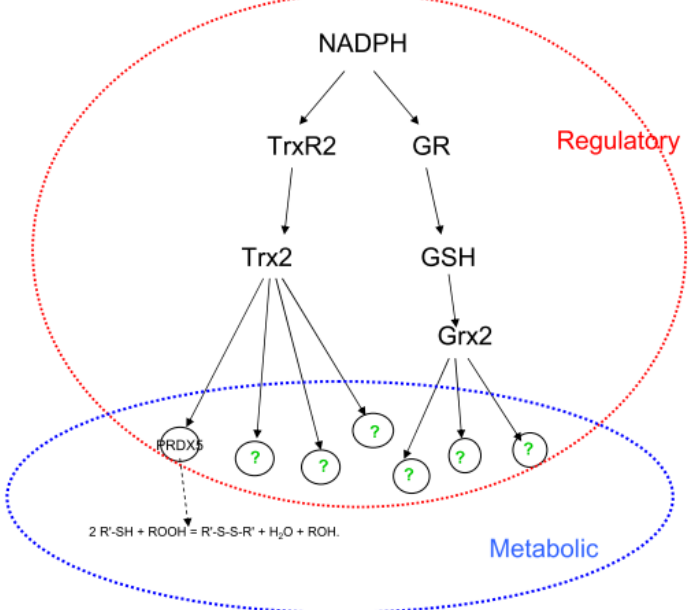
Fig. 1: Redox regulatory network and exemplarily affected metabolic network. Abbreviations: TrxR: thioredoxin reductase [9], GR: glutathione reductase, GSH: glutathione, Grx2: